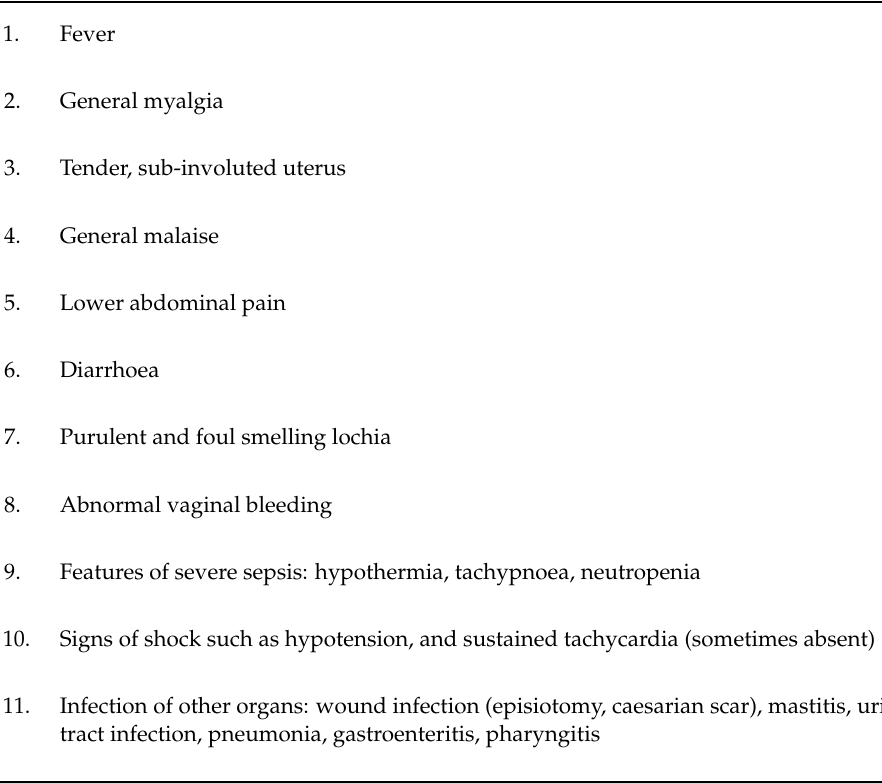
Table 6. Clinical features of iGAS (pre-)sepsis in Ob/Gyn patients